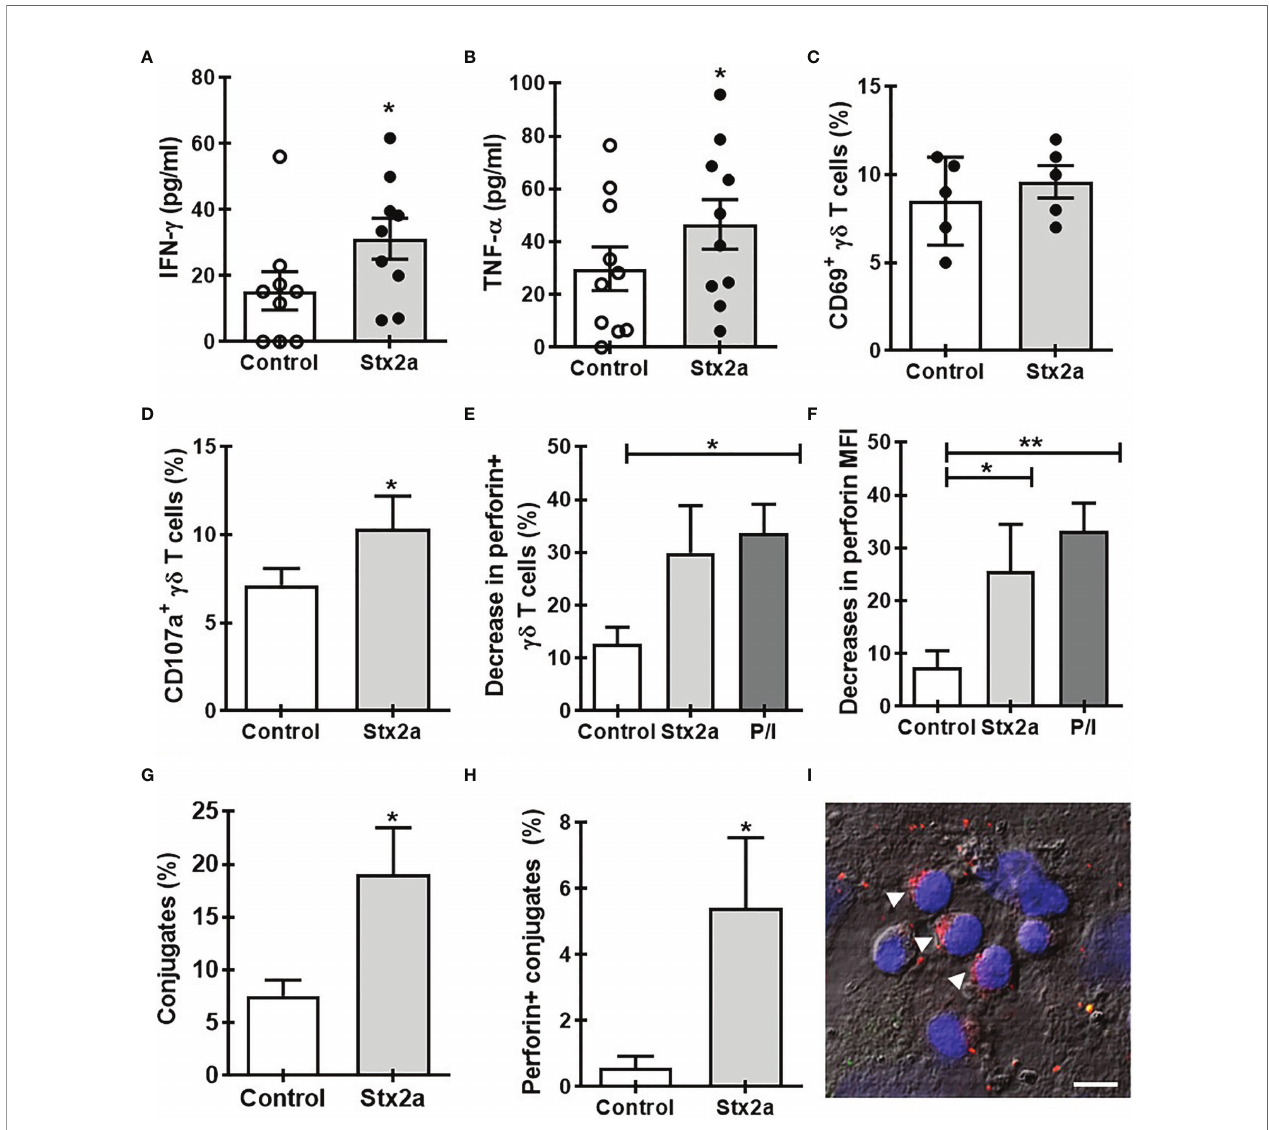
FIGURE 2 | Soluble factors released by Stx2a-stimulated HGEC activate gd T cells. gd T cells were cultured overnight at 37°C with conditioned media obtained from con fl uent monolayers of HGEC, treated (Stx2a) or not (Control) with Stx2a (0.01 ng/ml, 24 h). After overnight incubation, supernatants and cells were collected. (A, B) IFN- g and TNF- a released to the medium determined by ELISA, n=9 and n=10, respectively. Biological replicates. Kruskal-Wallis test, with Dunn ’ s multiple comparisons test. (C – F) Flow cytometry analysis of the expression of CD69 (C) (n=5), CD107a (D) (n=9), and perforin (E) (n=5) and (F) (n=10) in gd T cells. PMA and ionomycin (P/I) were used as a positive control. (G, H) gd T cells were seeded on glass slides previously coated with HGEC treated or not (Control) with Stx2a (0.01 ng/ml, 24 h) (for details see the section Methods ). After incubation, the number of gd T cells interacting with HGEC (conjugates) and the expression of perforin were evaluated by confocal microscopy. (G) Percentage of cell conjugates in non-treated (Control) or Stx2a-stimulates HGEC (Stx2a) (n=10, technical replicates). (H) Percentage of perforin+ gd T cells in interaction with HGEC non-treated (Control) or treated with Stx2a (Stx2) (n=10, technical replicates). (I) Representative image of perforin expression (red) in gd T cells in co-culture with Stx2a-treated HGEC. For nuclear visualization, cells were stained with ToPro-3 (blue). The fi gure shows one of two independent experiments performed. Bar: 10 µm. Arrows indicate gd T cells in which perforin are polarized. Results are shown as the mean ± SEM. * p < 0.05 and ** p < 0.01; (A – D, G, H) Wilcoxon or Mann-Whitney test. (E, F) Kruskal-Wallis with the Dunn ’ s multiple comparisons